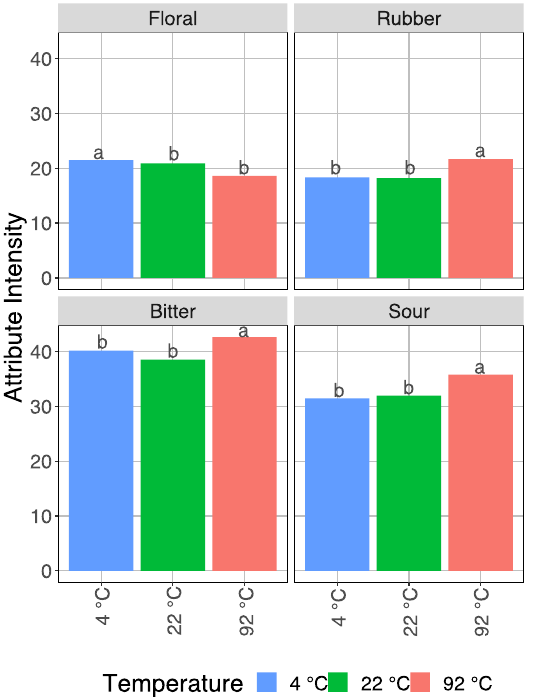
Figure 4. Sensory attributes with significant differences by temperature across all roasts and origins with LSD letter codes indicating significant difference.